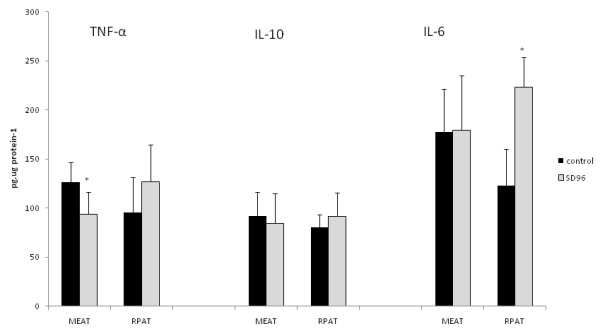
Cytokines levels.